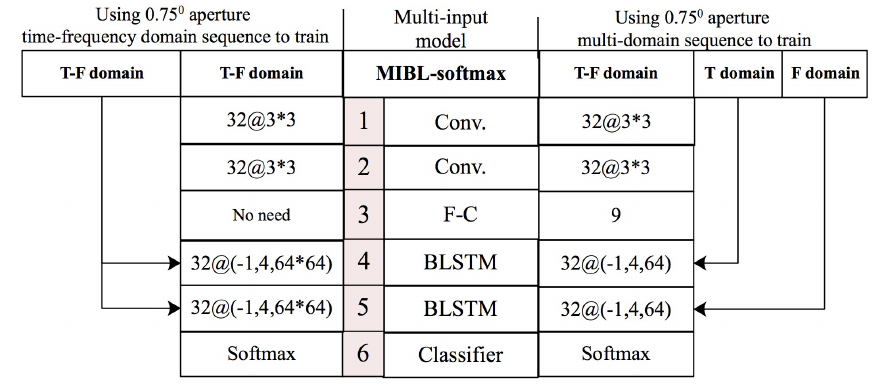
Figure 12. MIBL-softmax model.